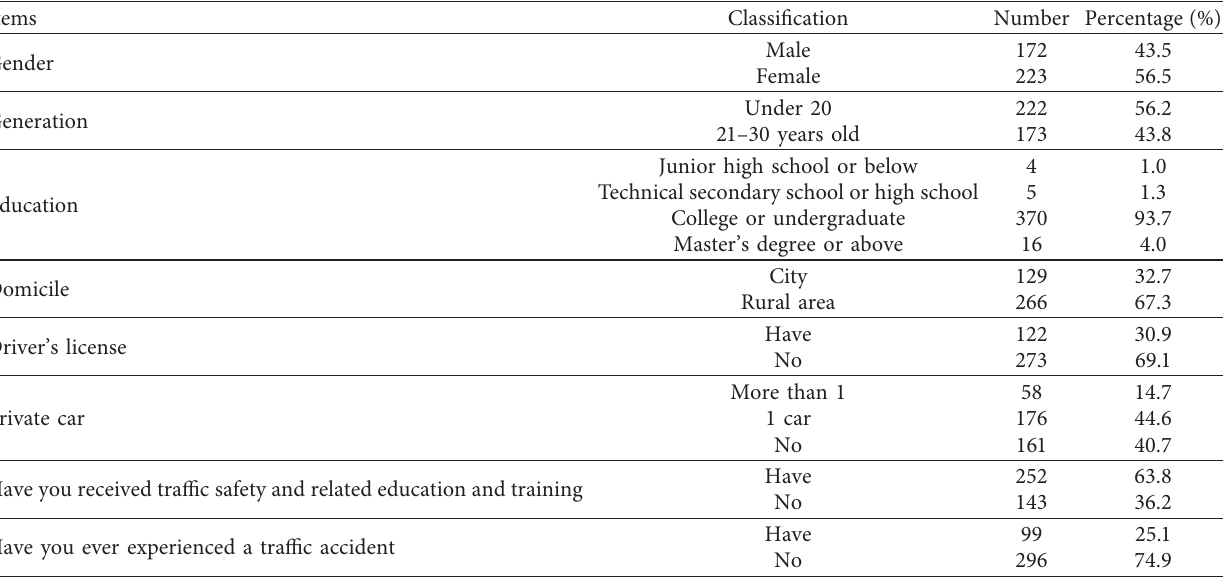
Table 4: Demographic and descriptive statistical analysis ( N � 395).